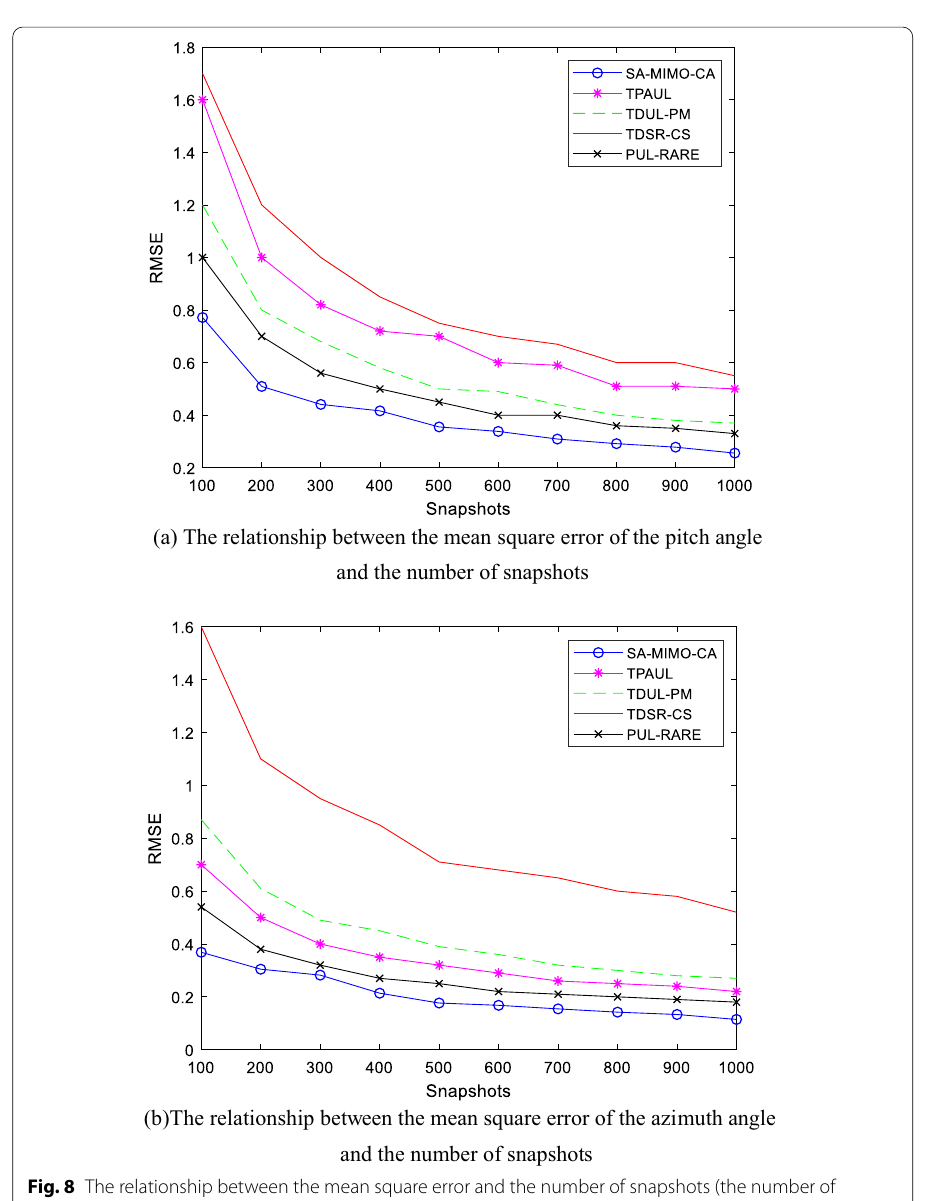
Fig. 8 The relationship between the mean square error and the number of snapshots (the number of sources is 3)